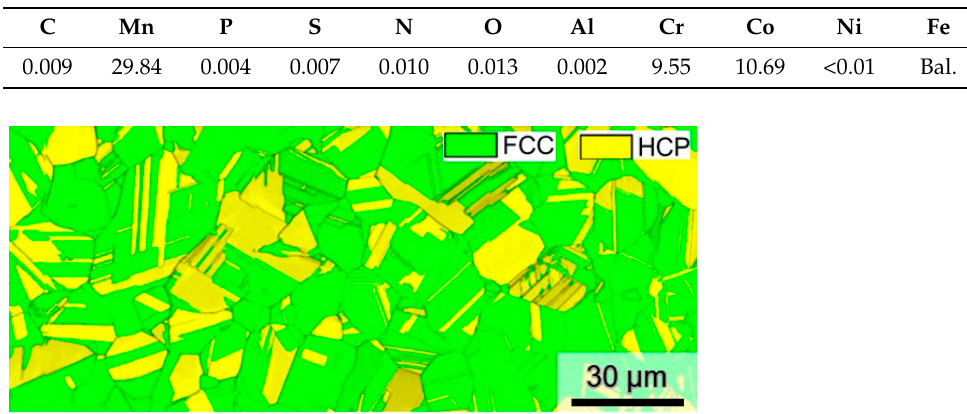
Figure 1. Phase map showing an overview of the as-solution-treated microstructure.